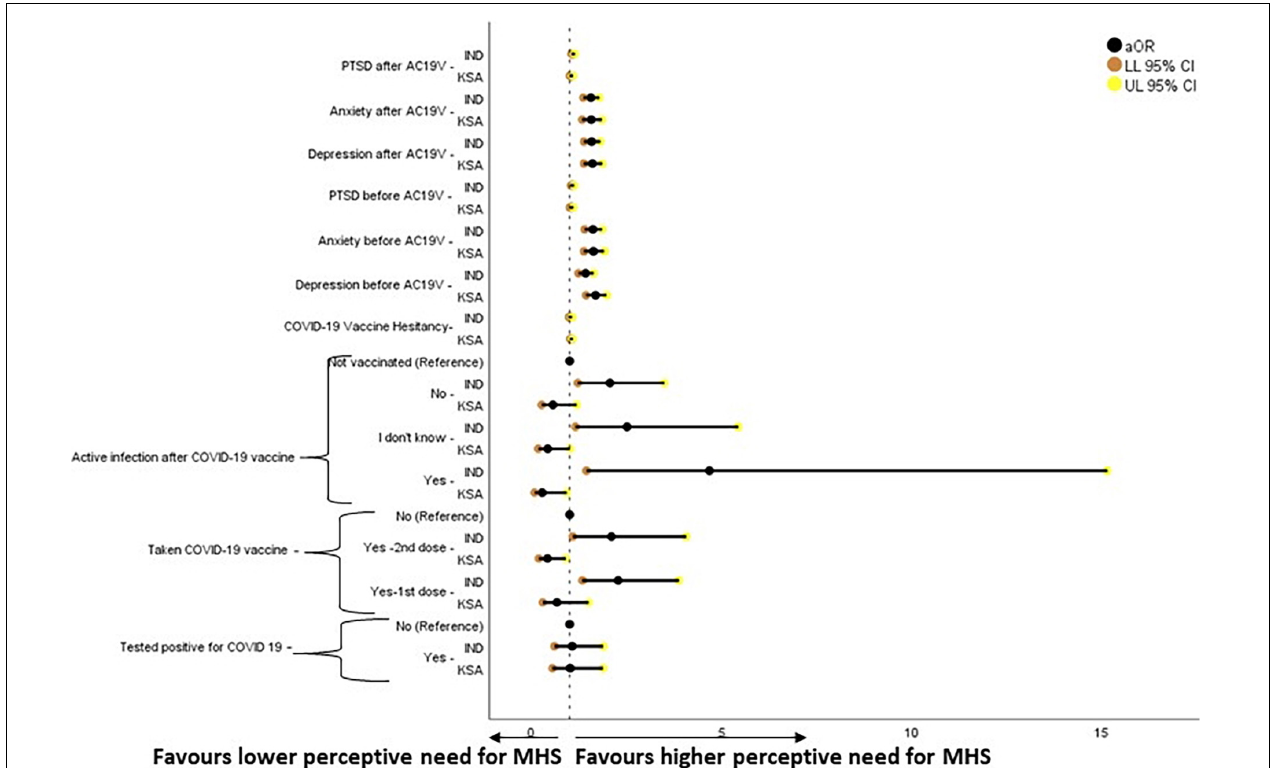
FIGURE 8 | Forest plot showing adjusted binary logistic regression analysis of perception of need for Mental Health Support (regression model 2). aOR, adjusted Odds Ratio; Odds ratio adjusted for Sociodemographic factors. 95% CI, 95% Confidence Interval. The results of regression model 1, 2, and 3 in binary logistic regression analysis of depression scores is tabulated in Supplementary Table 15